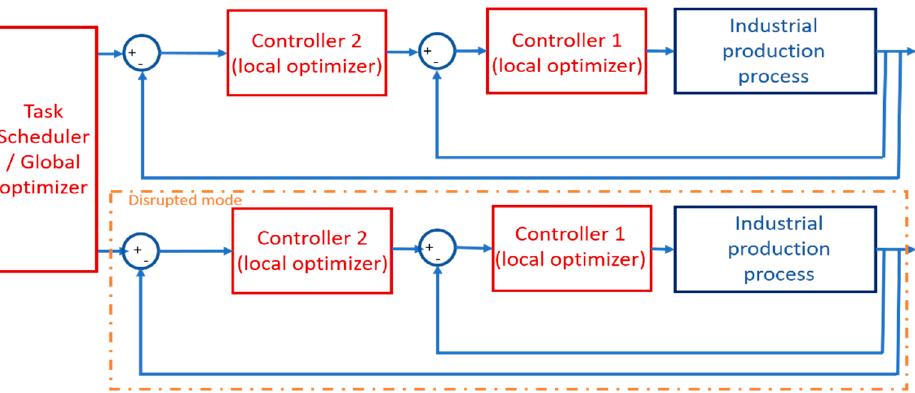
Figure 4. Optimized reactive control architecture (ORCA) [75].